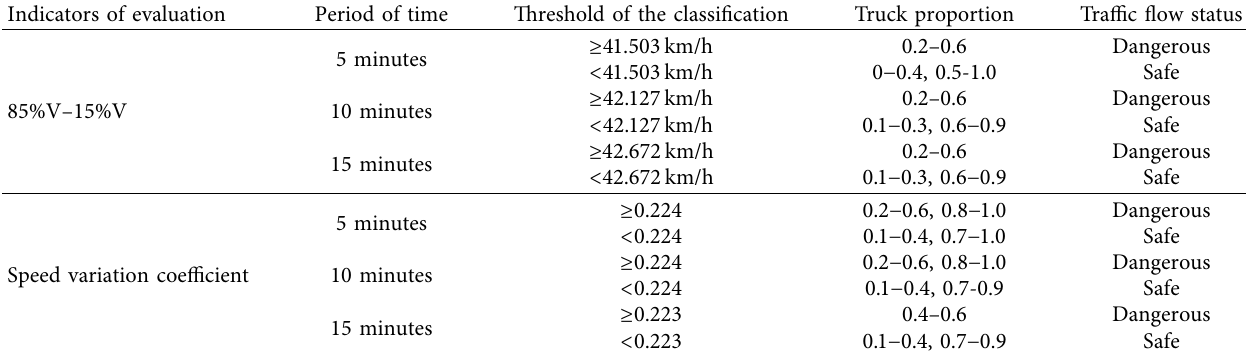
Table 6: Traffic status level of the classification of indicators and truck